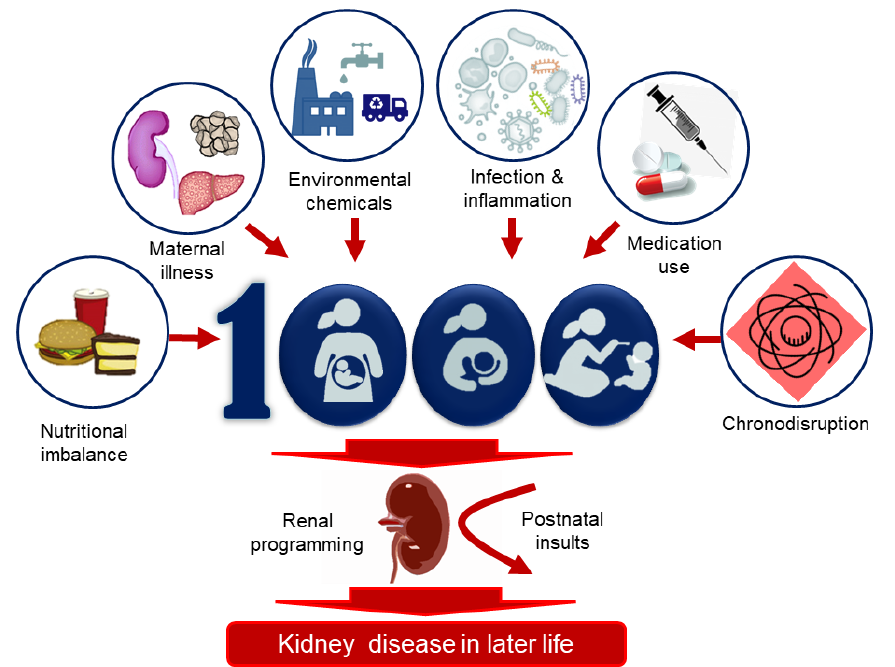
Figure 2. Various environmental factors during the first 1000 days of life are associated with renal programming, resulting in kidney disease in later life. These risk factors include nutritional imbal- ance, maternal illness, environmental chemicals, infection and inflammation, medication use, and chronodisruption.